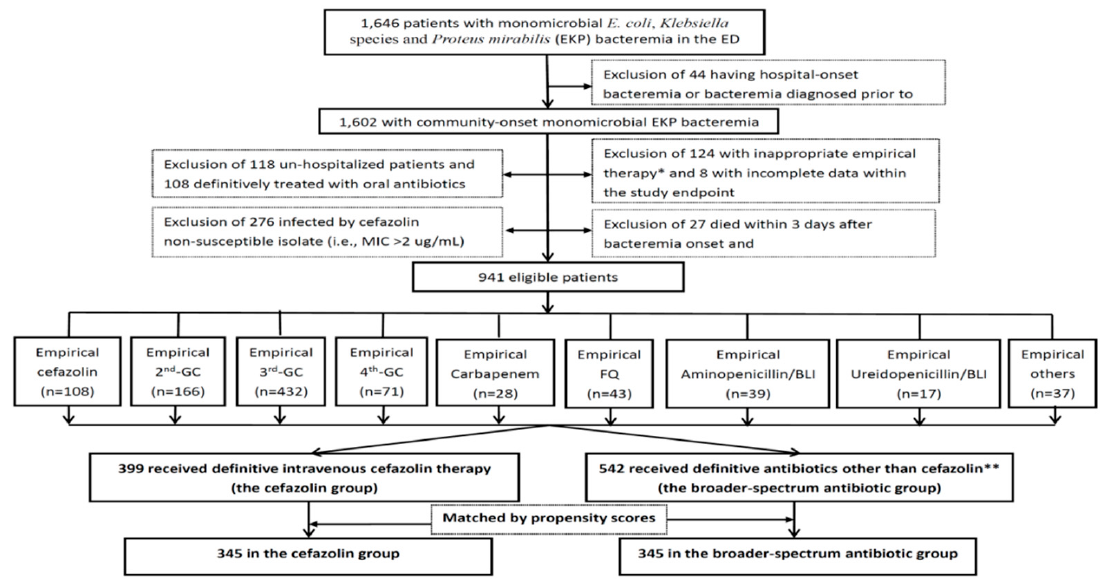
Figure 1. Flowchart of patient selections. * Indicate the time to appropriate antibiotic of > 24 h. ** Included 235 patients with third-GCs, 154 with second-GCs, 24 with carbapenems, 60 with FQs, 30 with fourth-GCs, 21 with ampicillin / sulbactam, 13 with piperacillin / tazobactam, 3 with piperacillin, and 2 with others. ED = emergency department; GC = generation cephalosporin; FQ = fluoroquinolone; BLI = β -lactamase inhibitor.